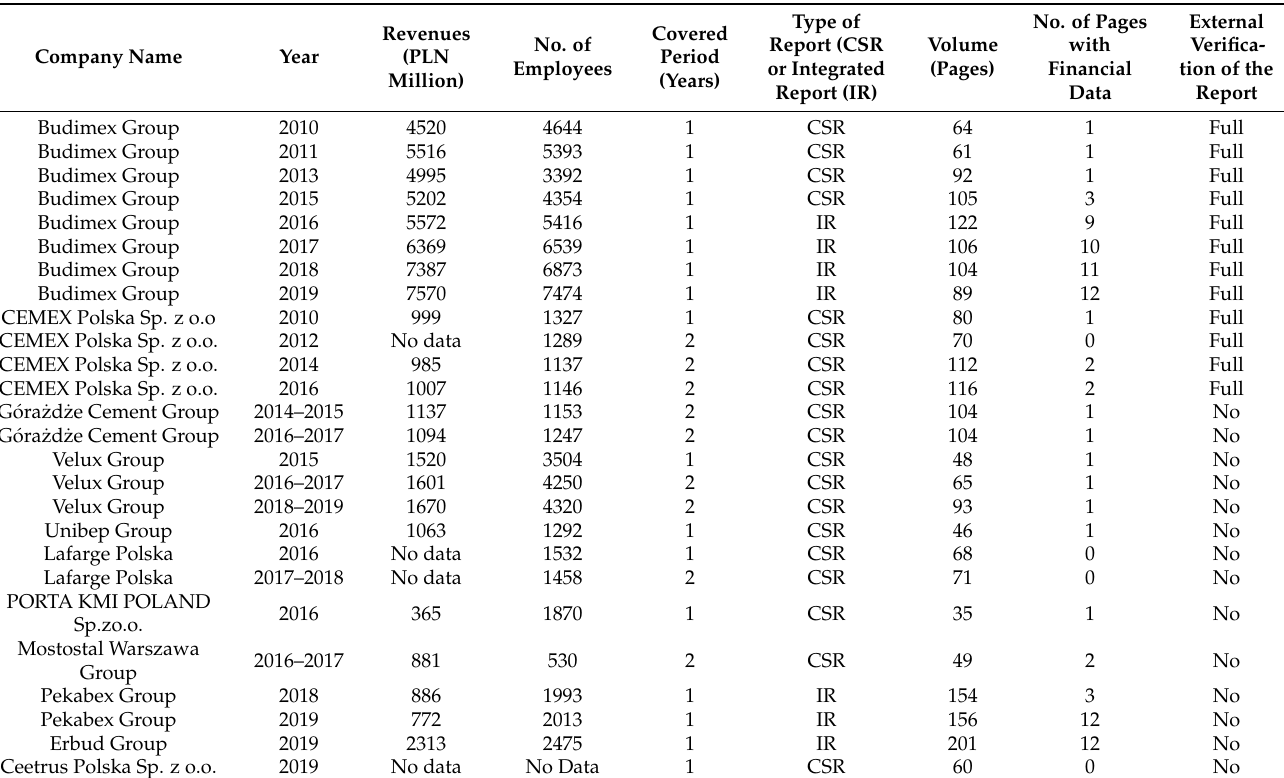
Table 1. Overview of analysed CSR and integrated reports of enterprises operating in the construction and property development industry